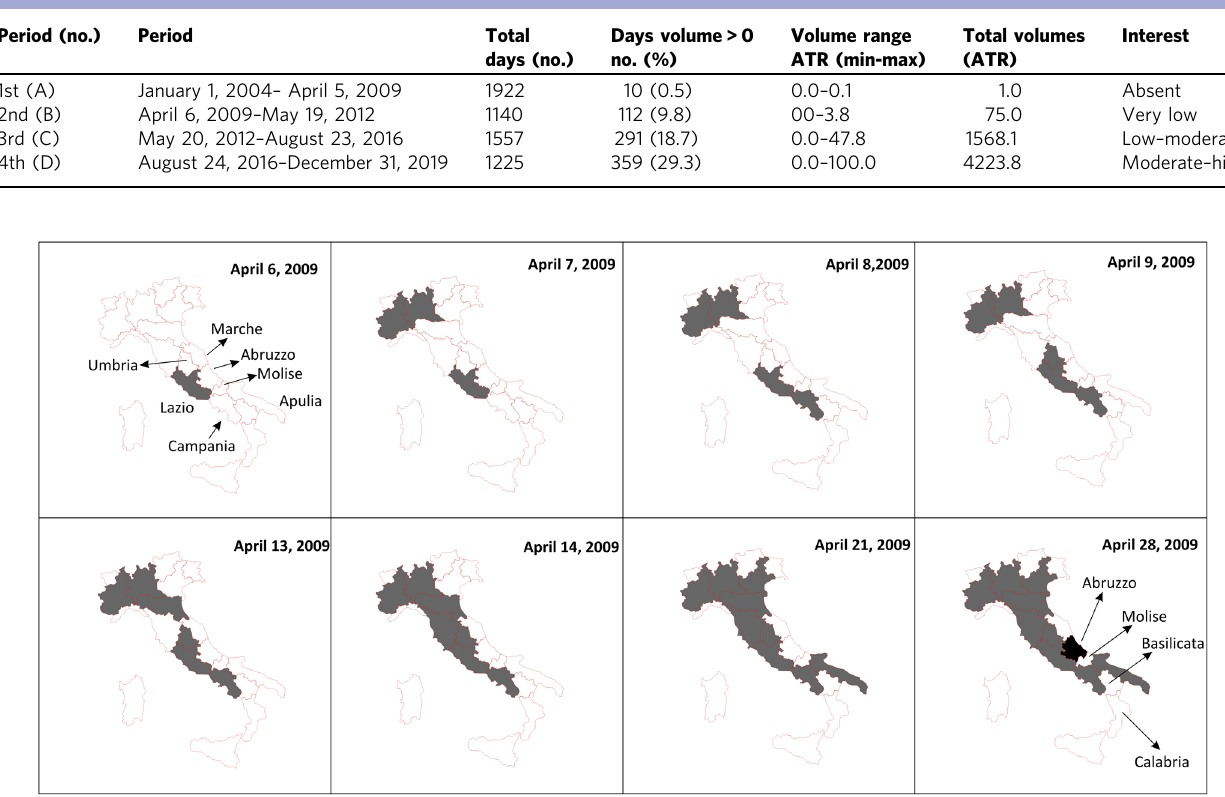
Fig. 2 2009 Abruzzo earthquake. Spread of internet searches (GMs) across Italy for ATR. Each GM represents the overview of the Italian regions involved in the searches from April 6, 2009 to the indicated